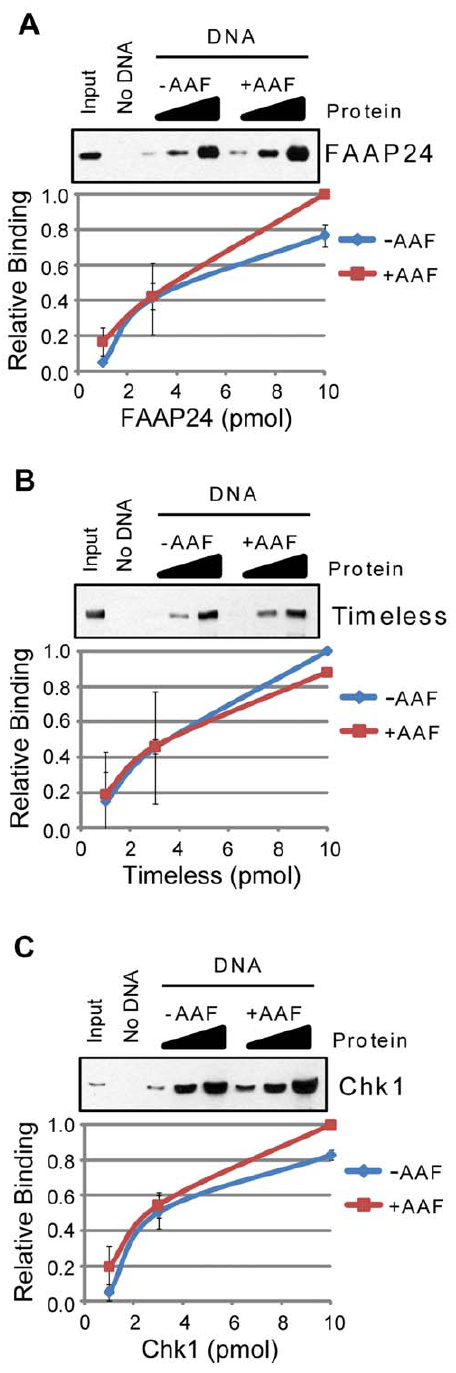
Figure 6. FAAP24, Timeless, and Chk1 do not preferentially bind AAF-damaged DNA. The association of each of the indicated purified proteins with beads alone (No DNA) or to undamaged ( 2 AAF) or N -acetoxy-2-acetylaminofluorene (AAF)-treated ( + AAF) plasmid DNA bound to magnetic beads was analyzed by SDS-PAGE and immuno- blotting. Each of the following proteins was analyzed for binding to each DNA structure: (A) FAAP24, (B) Timeless, and (C) Chk1. Reactions were carried out as described in the Methods section.